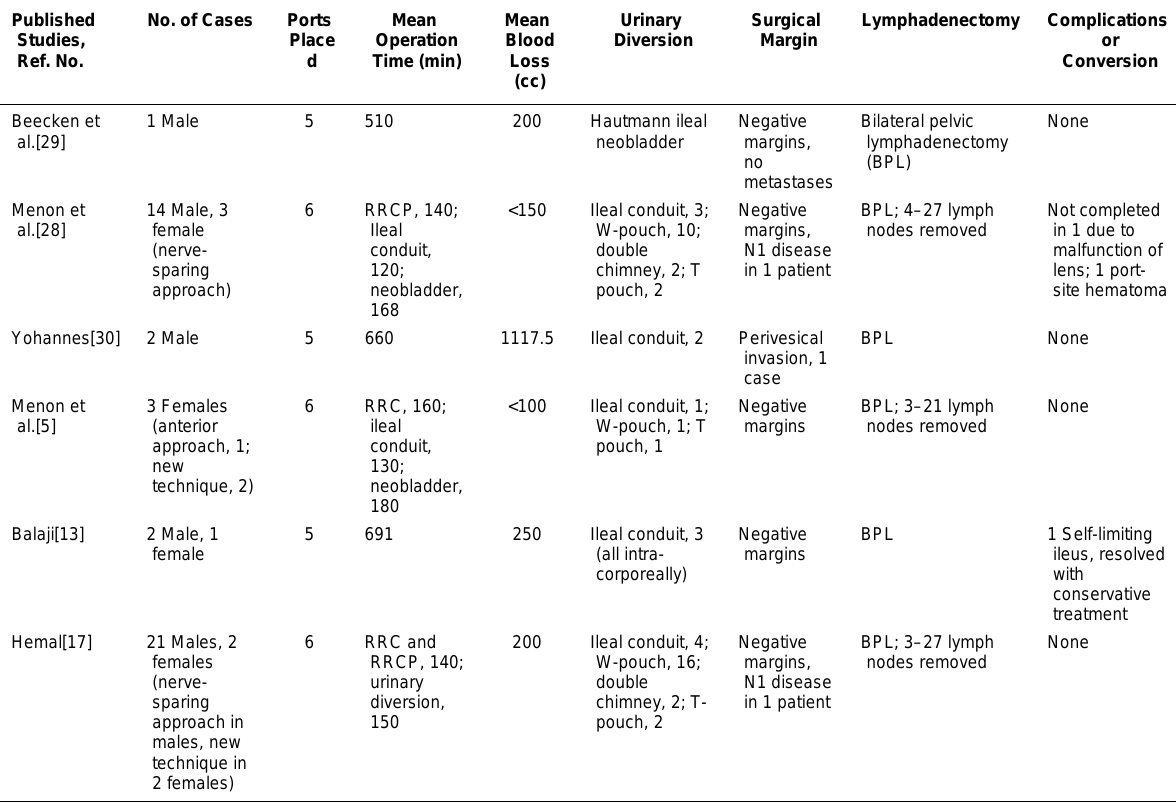
Published Articles on Robotic Radical Cystectomy and Urinary